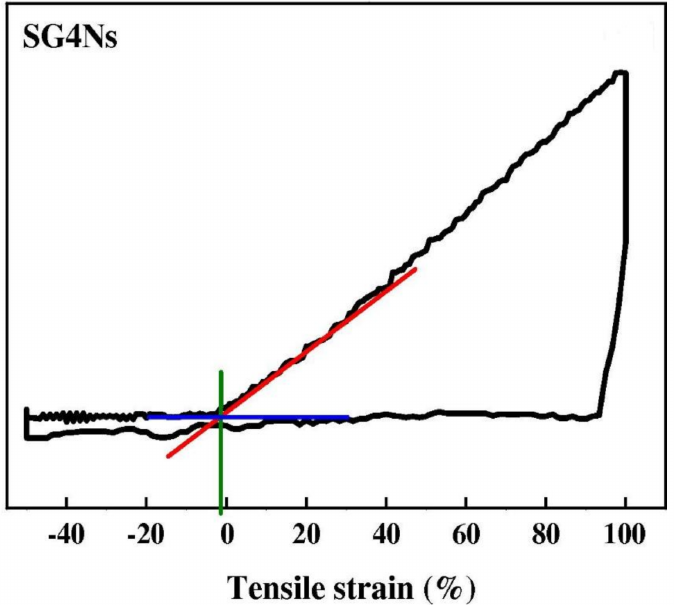
Figure 13. Thermal-shrinkage during physical-testing of pristine SMPU/GO nanofibrous mats. Reproduced with permission from